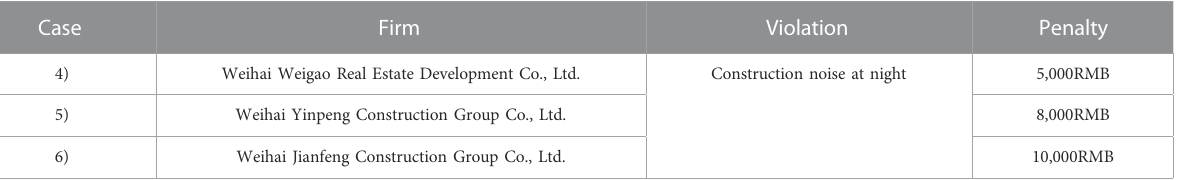
TABLE 2 Cases of environmental administrative penalties in Weihai City in 2015 4